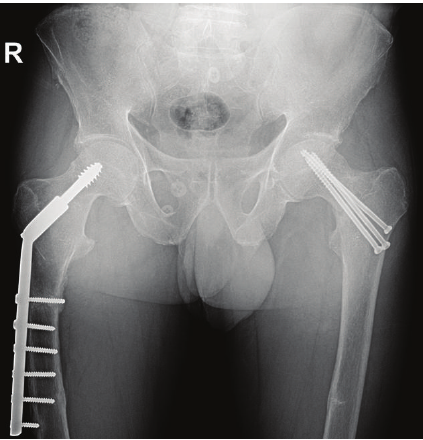
Figure 1: Anteroposterior X-ray showing bilateral hip fracture that underwent screwing.